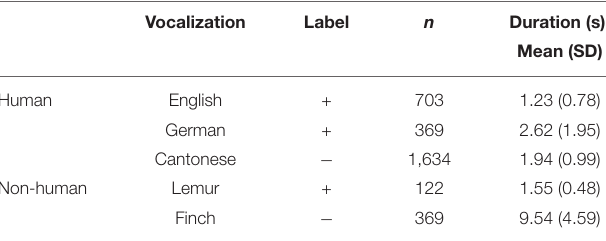
TABLE 1 | Descriptive statistics of dataset for vocalizations that do (+) and do not ( − ) support object categorization, from the vantage point of 4-month-old English-acquiring